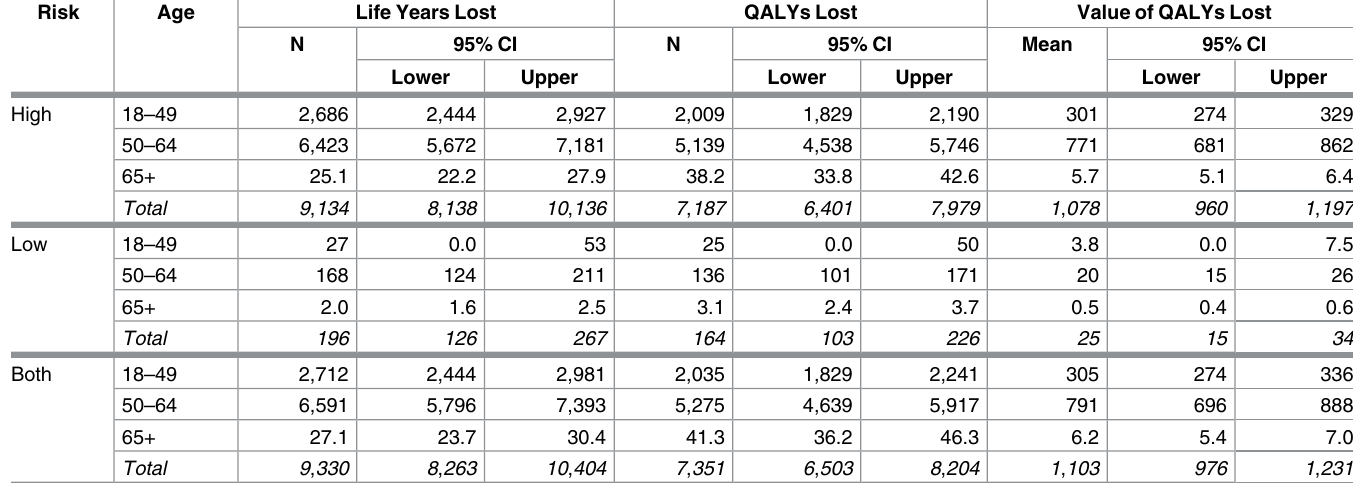
Table 10. Annual estimates of influenza-attributed life years lost, quality adjusted life years(QALYs) lost and monetary value of QALYs lost by risk and age group in millions of US Dollars averagedover five respiratoryseasons. Risk